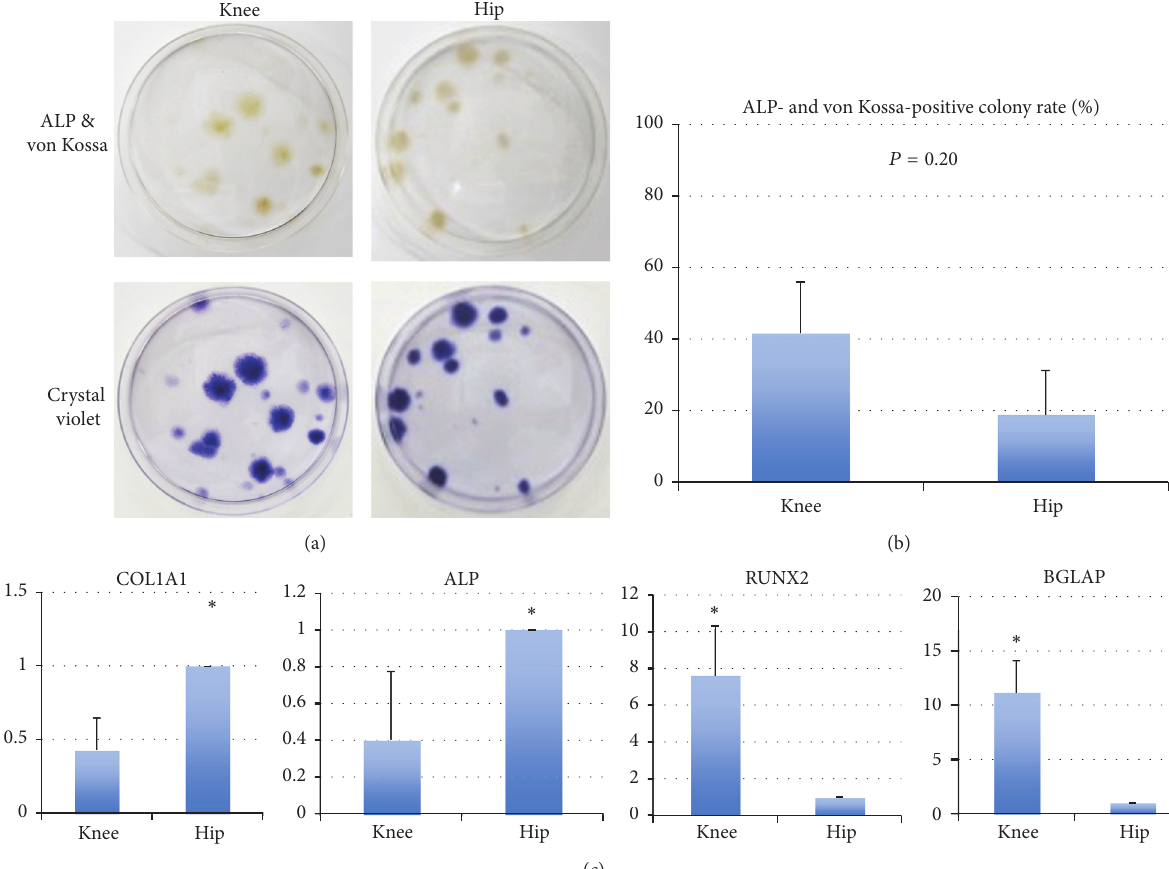
Figure 6: Osteogenic potential of each type of MSCs. (a) Colonies stained positively with von Kossa and ALP as well as crystal violet. (b) Proportion of von Kossa and ALP-positive colonies in relation to the total number of colonies. Values are the mean and standard deviation of 6 donors. ∗ There was no significant difference in the rate of von Kossa and ALP-positive colonies between knee and hip (Mann–Whitney U test, 𝑃 = 0.20 ). (c) Real-time RT-PCR. Gene expressions of COL1 and ALP in knee were significantly lower than those in hip (Mann– Whitney 𝑈 test, 𝑃 < 0.05 ); on the other hand gene expressions of RUNX2 and BGLAP in the knee were significantly higher than in the hip (Mann–Whitney 𝑈 test, 𝑃 < 0.05 ). The bar means standard